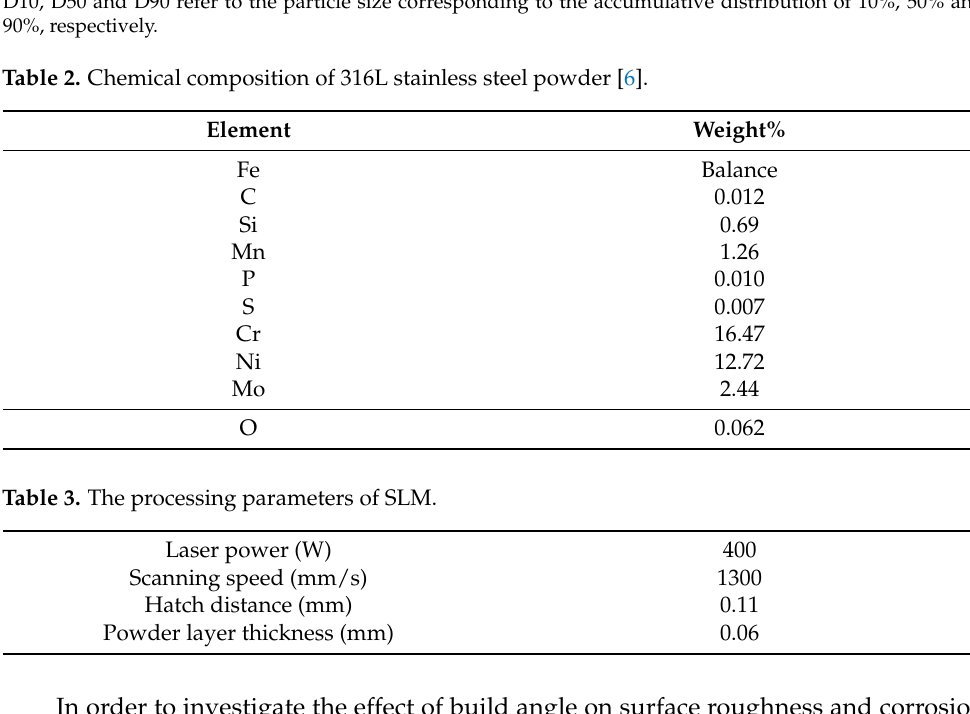
Table 2. Chemical composition of 316L stainless steel powder [6].